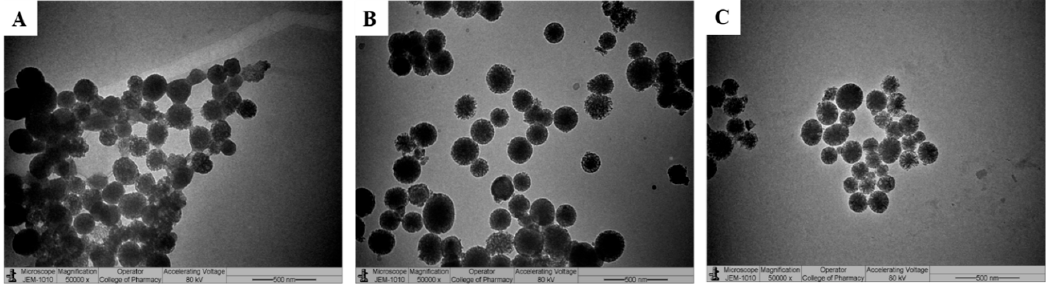
Figure 4. TEM images of MSN-NH 2 after drug loading. DEX MSN-NH 2 ( A ), 5-FU MSN-NH 2 ( B ), and combined MSN-NH 2 ; mixed DEX MSN-NH 2 and 5-FU MSN-NH 2 (1:1 ratio) ( C ). bar = 500 nm.